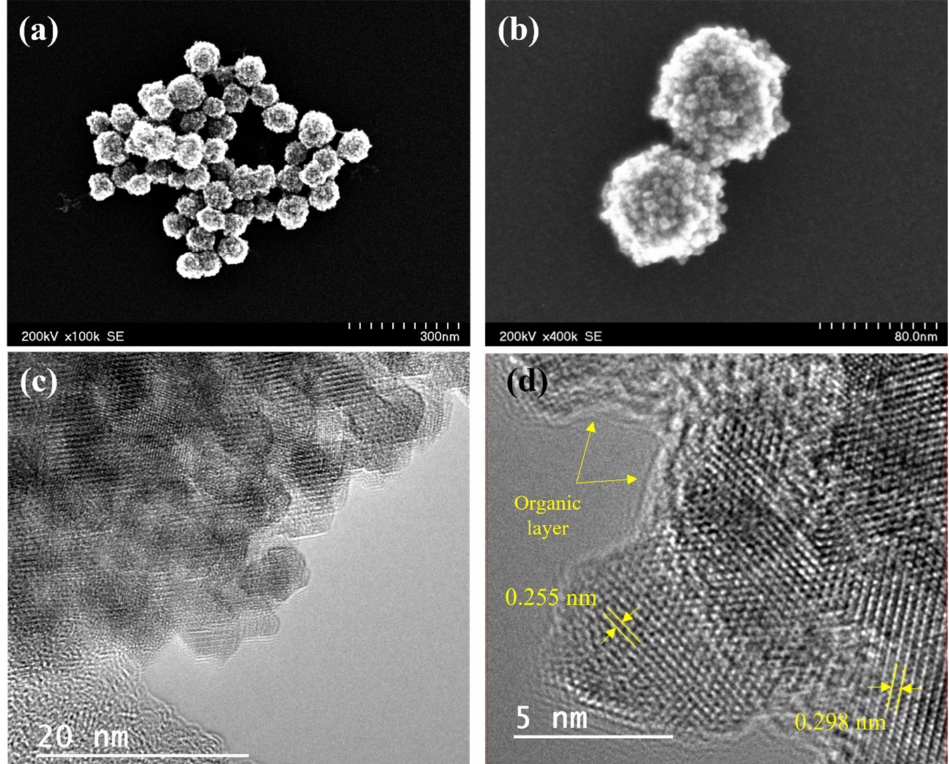
Figure 4. ( a , b ) STEM images of magnetic clusters. ( c ) HRTEM image of the magnetic nanoclusters with the organic layer at their surface. ( d ) HRTEM image with the interplanar distance corresponding to the family of crystalline planes (220) and